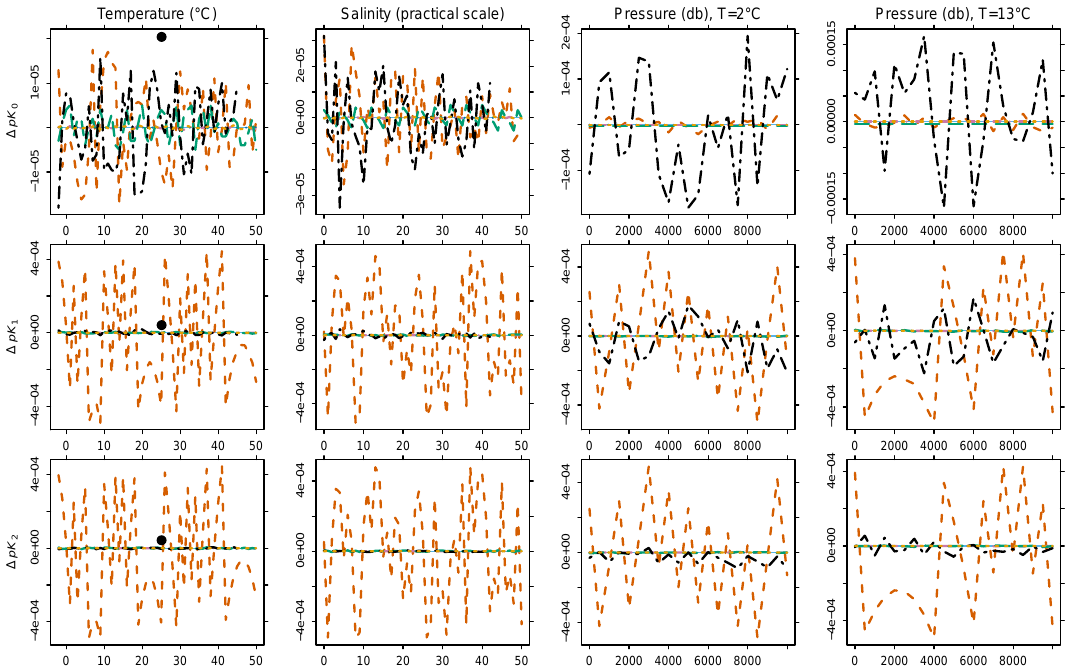
Figure 13. The p K 0 (top), p K 1 (middle), and p K 2 (bottom) computed with each package minus corresponding values for CO2SYS- MATLAB. Formulations are those recommended for best practices, namely K 0 from Weiss (1974) and K 1 and K 2 from Lueker et al. (2000). Constants were computed across the same ranges of T (column 1), S (column 2), and P when T = 2 ◦ C (column 3) and when T = 13 ◦ C (column 4) as used in previous figures. Constants from CO2calc and ODV were not directly available but are estimated from variables computed with the A T – C T pair. The filled black circles indicate the check values (Table 12). Line signatures are as in Fig. 5.